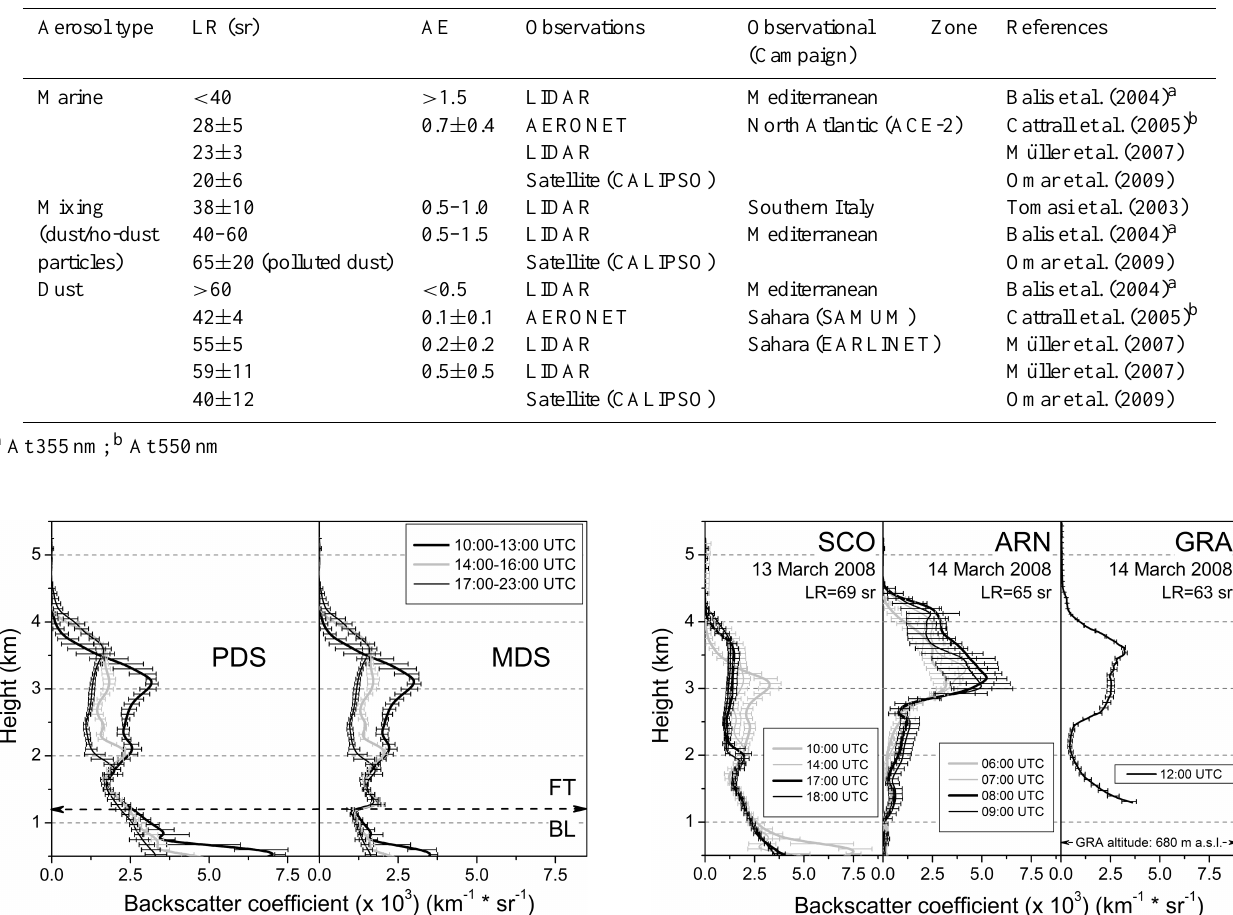
Table 4. LR values (at 532nm) reported by several reference works together with other information for aerosol-type discrimination criteria.